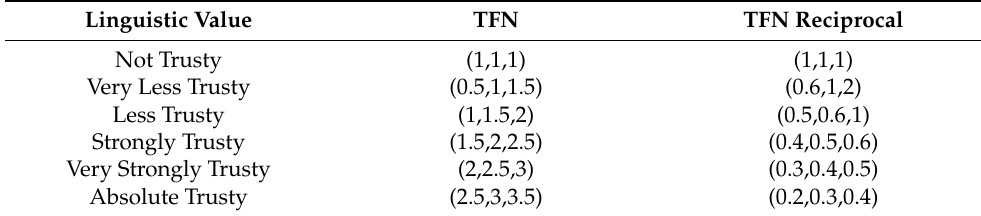
Table 4. Comparative significance of trust-based fuzzy scale.